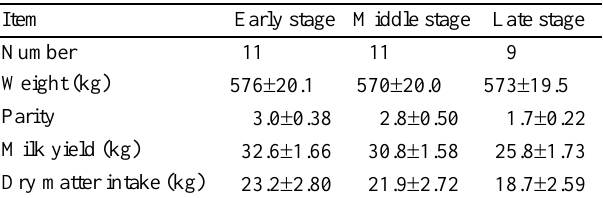
Table 1. Design of experiment 1